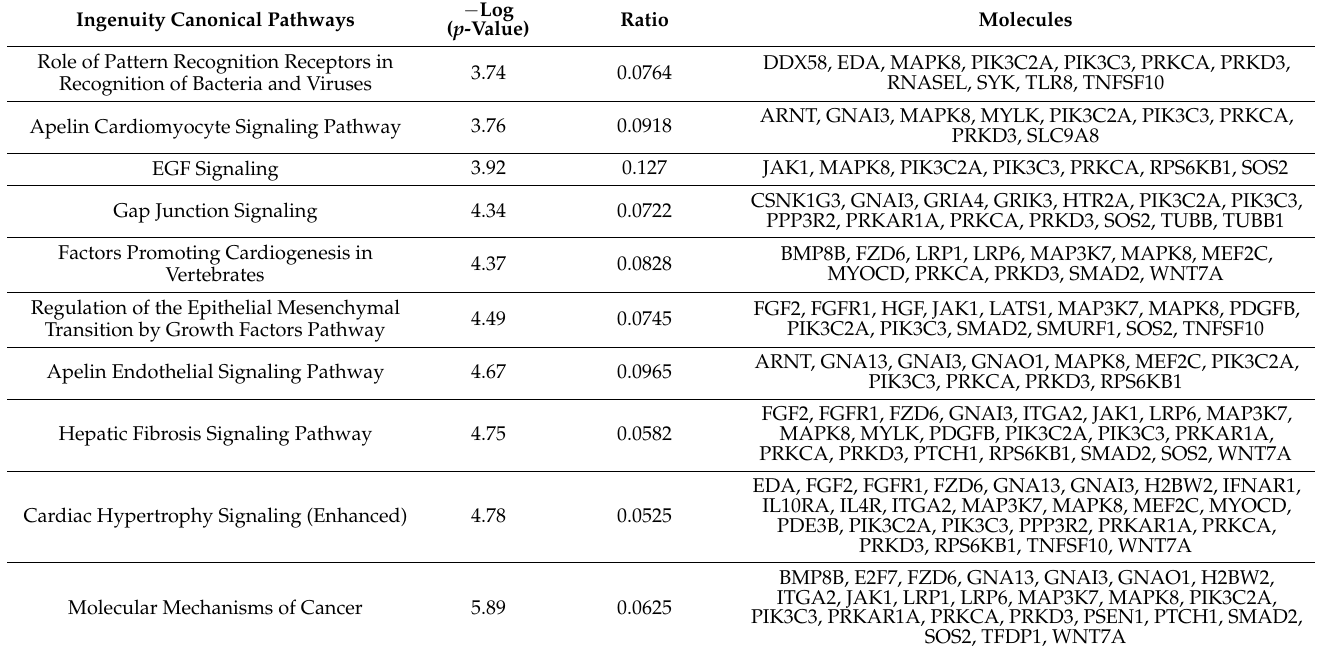
Table 1. Canonical pathway of the predicted target genes of miR-545-3p according to the IPA database.